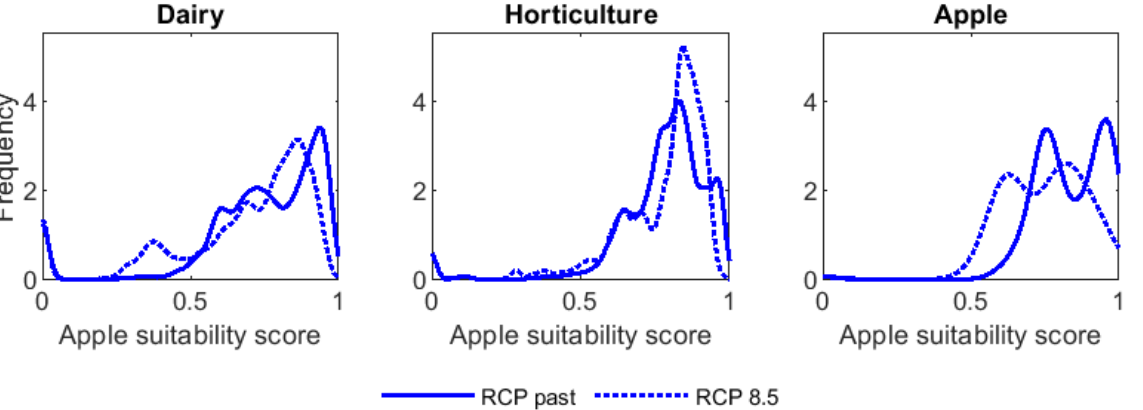
Figure 9. Changes in apple suitability (Representative Concentration Pathway (RCP) past vs. RCP 8.5) by current land use. Horticulture represents horticultural industries other than apple and ki- wifruit.